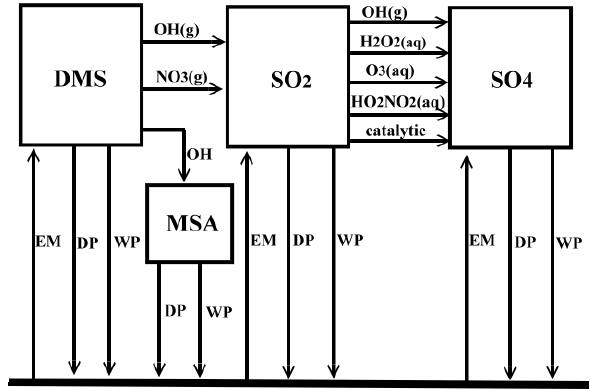
Fig. 1. Sulfur cycle in GCCM. Four species including DMS, MSA, SO 2 and sulfate are included. The arrows are different fluxes includ- ing emission ( EM ), dry deposition ( DP ) and wet deposition ( WP ) and gas phase ( g ) and aqueous phase (aq)